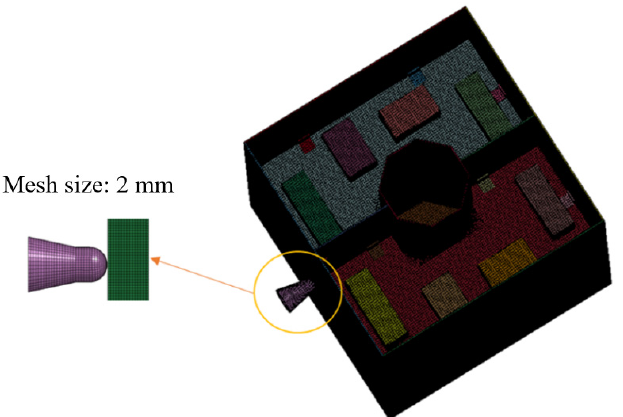
Figure 25. Schematic diagram of meshing for the model of projectile impact on simulated satellite by finite element method-smooth particle hydrodynamics method.